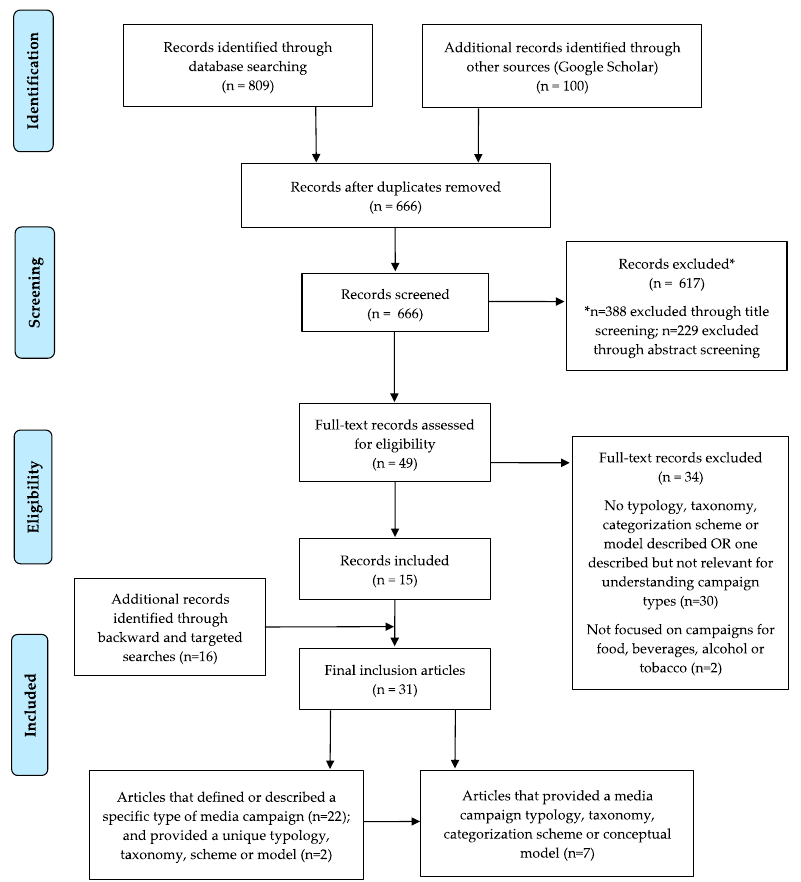
Figure 1. PRISMA flow diagram for the systematic scoping review of evidence for media campaign models, taxonomies, typologies and categorization schemes.